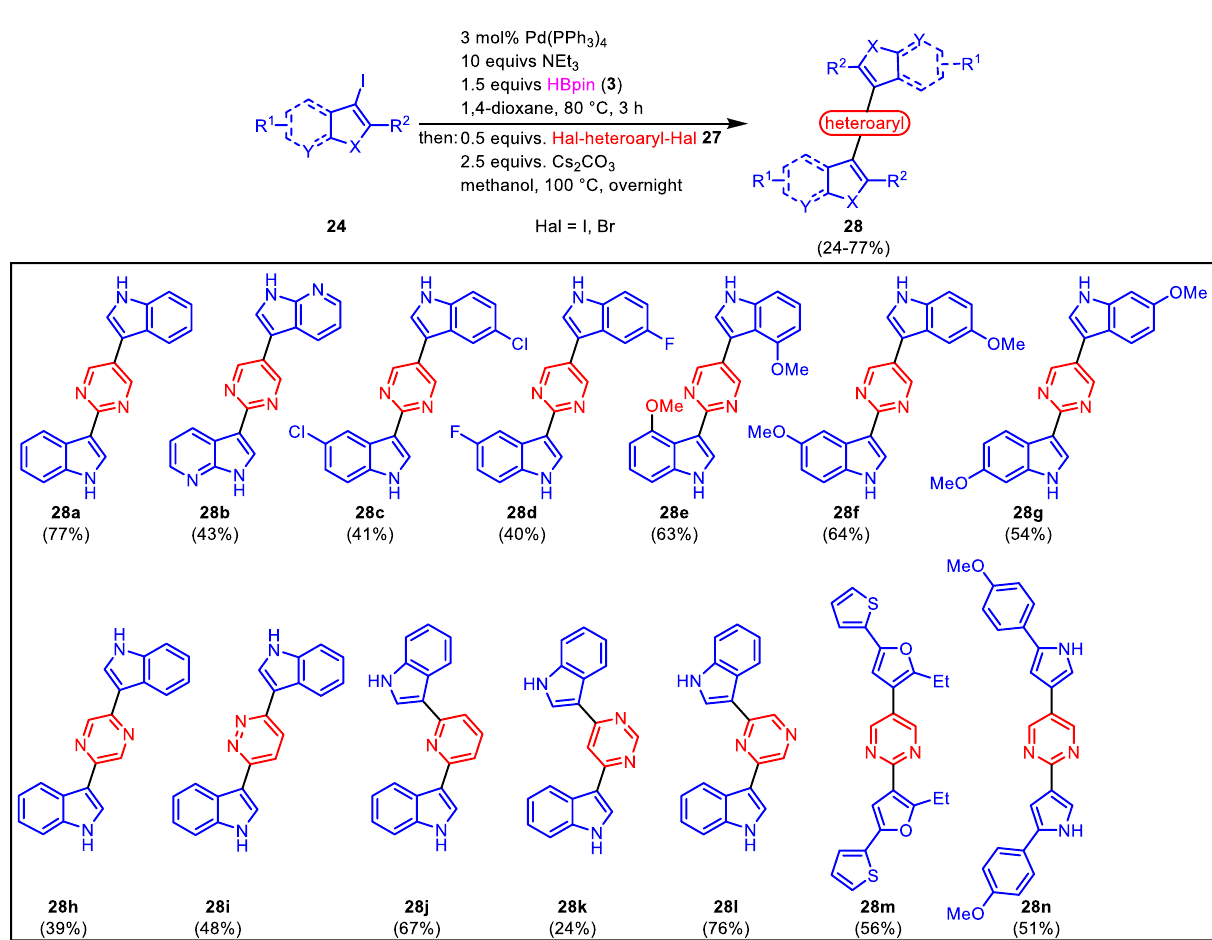
Figure 17. One-pot MBSC synthesis of (di)azine-bridged bisindoles 28 by Tasch et al. [48]. Tasch et al. continued to extend the product scope of the MBSC sequence. The reaction of 5-membered heterocycles as the coupling partner in the Suzuki step appeared to be challenging; the yields were either low or the coupling did not proceed at all under standard conditions. Exchanging cesium carbonate with sodium carbonate, as well as the addition of catalytic amounts of triphenylphosphane to prevent the Pd species from precipitation in the Suzuki coupling, led to higher yields. Additionally, instead of methanol, water was employed as a solvent to improve the solubility of the base. With these optimized conditions, indoles 24 have been reacted with equimolar amounts of bromo thiazoles 29 , which furnished camalexin derivatives 30 in yields ranging from 31 to 75% (Figure 18). In the case of 30i , the corresponding dibromo thiazole was employed to give the thiazole-bridged bisindole 30i , an analogue of the biologically active alkaloid nortopsentin. Its isomer could not be isolated; instead, bromo-substituted camalexin derivative 30h was isolated [50].